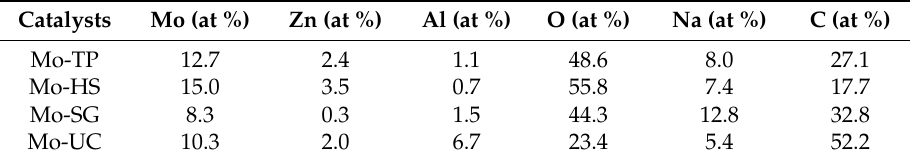
Table 2. Chemical composition obtained by the XPS spectra of the Mo/ZnAl-LDH catalysts. Catalysts